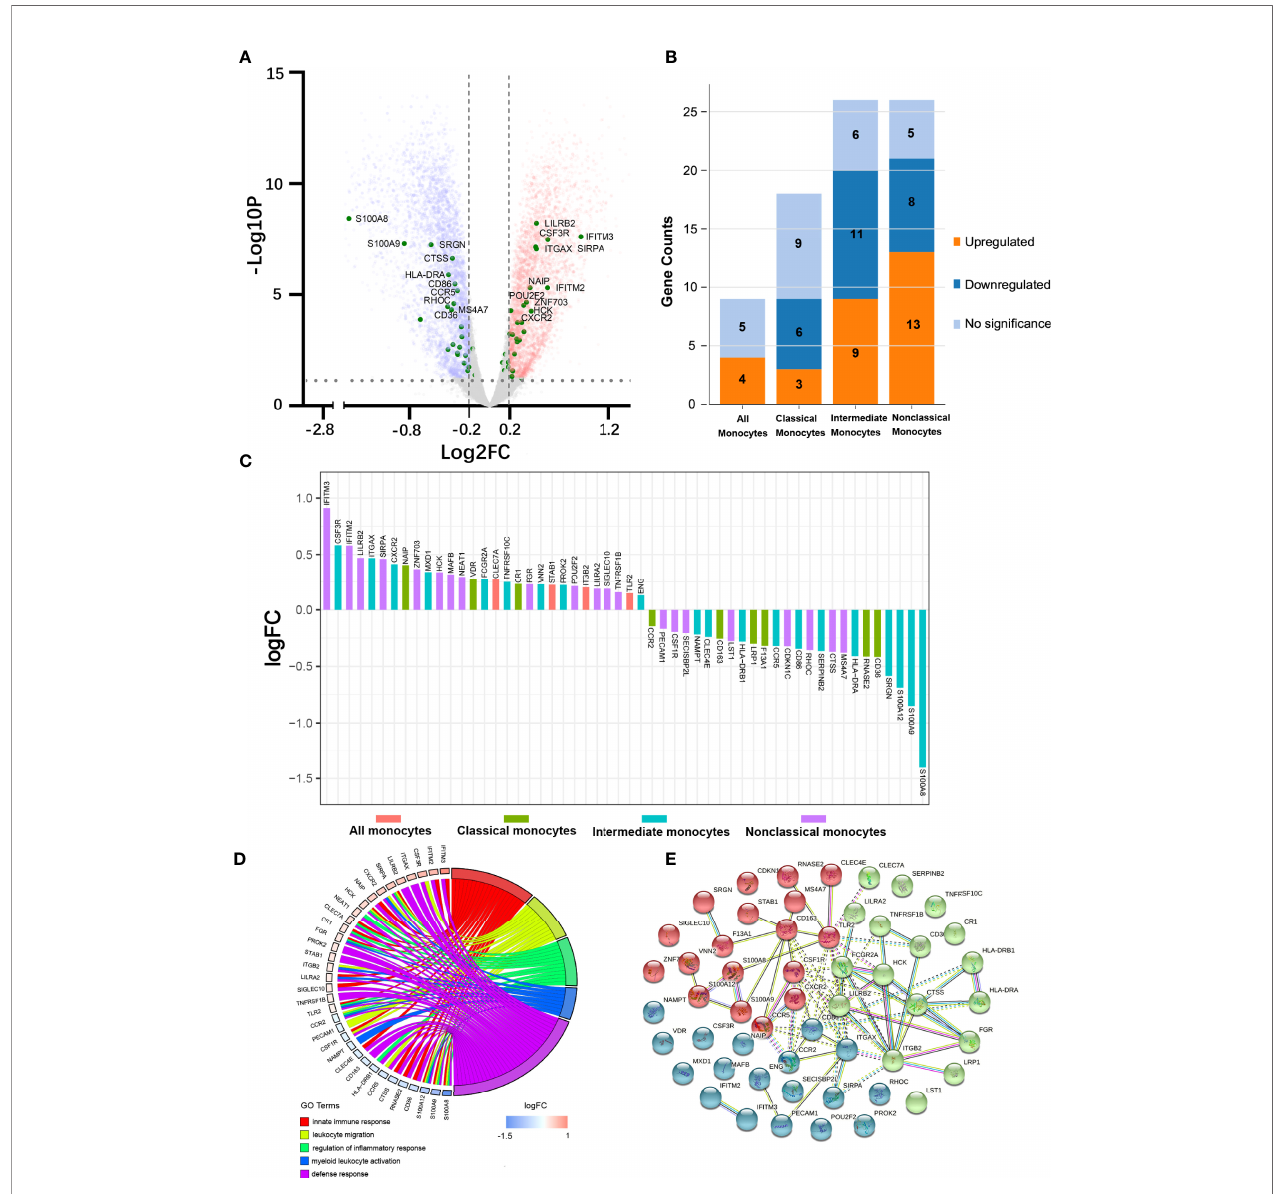
FIGURE 1 | Peripheral blood RNAseq transcriptomic pro fi ling shows differentially expressed monocytic genes between FES patients and HCs. (A) Volcano plot indicates the DEGs (FDR < 0.05, Log2FC > |0.2|), depicted as upregulated (red) or downregulated (blue), in FES patients compared to HCs. Fifty-four monocyte subset-speci fi c DEGs are highlighted (green) and those with -Log10 P > 3 are nominated. (B, C) These DEGs (FDR < 0.05) were especially enriched in intermediate and nonclassical monocytes. (D) Chord plot shows most of the 54 DEGs in association with the top nonoverlapping GOBP subontology terms, as analyzed in DAVID. Genes are ordered according to the observed Log2FC and linked to their assigned terms via colored ribbons. (E) PPI analysis shows the interactions of DEGs set at a high con fi dence threshold of 0.7 and clustered into 3 color-coded sets with k-means = 3. Line between nodes features the type/strength of an interaction according to annotations in String. See also Supplementary Tables 2 , 3